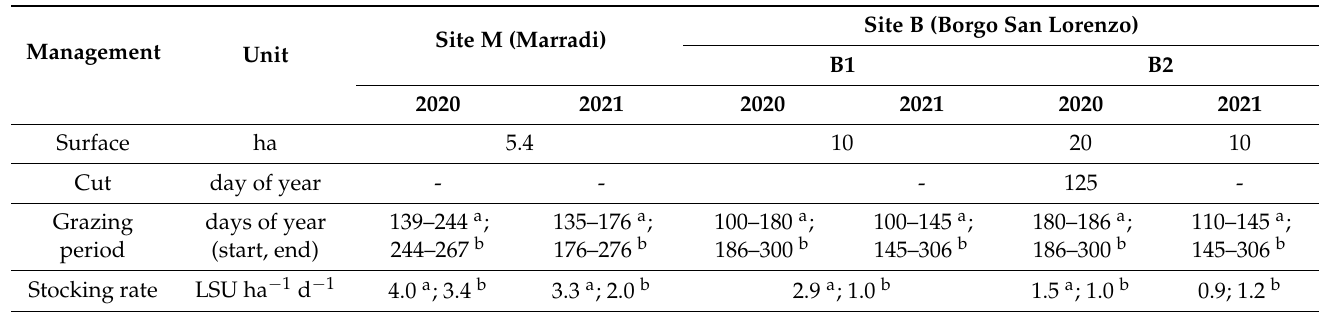
Table 2. Management of the two study sites. Livestock Standard Unit (LSU) refers to a dairy cow producing 3000 kg of milk per year, without additional concentrated feed (EC,